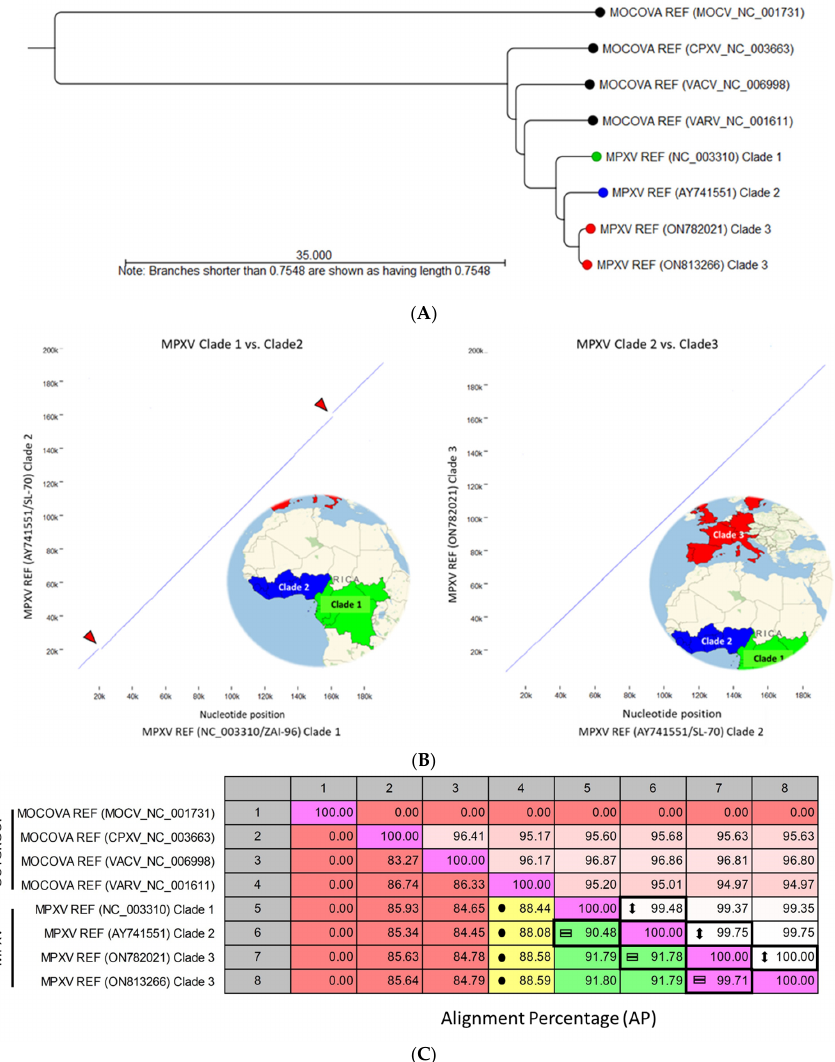
Figure 5. Comparative analysis of representative Monkeypox, Molluscipox, and other Orthopox vi ‐ ral genomes ( A ) Phylogenetic tree showing the genetic distances between MPXV and the Outgroup (MOCV, CPXV, VACV, VARV). The three clades of MPXV are distinct with intra ‐ clade genetic evo ‐ lution identified within Clade 3. See text for details regarding the representative Clade 3 samples. The NJ tree is rooted at MOCV; ( B ) Dot ‐ plot comparison of nucleotide similarity between MPXV Clades (1 versus 2) and (2 versus 3). The unbroken diagonal represents identity between two se ‐ quences. Breaks (red arrowheads) indicate significant differences. Specifically, MPXV REF (ZAI ‐ 96) Clade 1 possesses 3 genes which are deleted (D14L) or mutated (B10R and B14R) in Clade 2 located at the breaks near positions 20k and 168k, respectively. Clades 2 and 3 are genetically similar with ‐ out notable breaks; ( C ) Pairwise comparisons show 90% to 92% alignment similarity ( = ) between